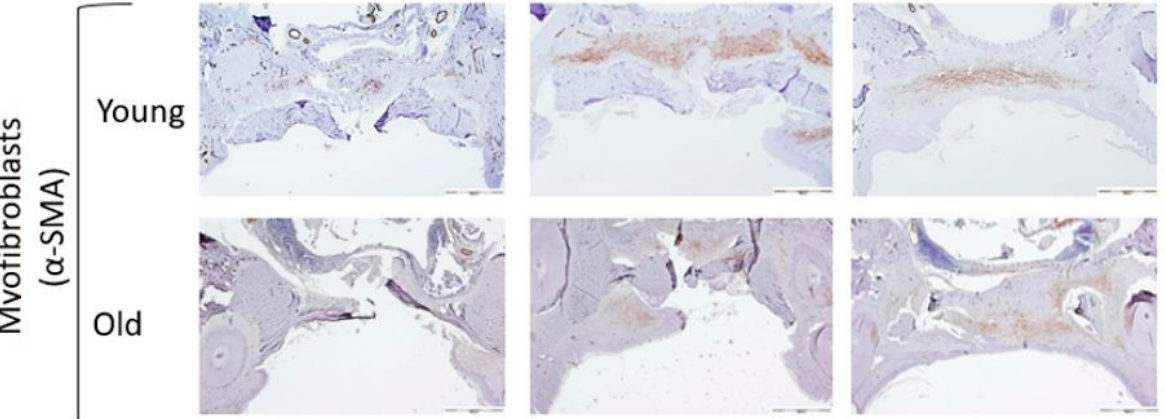
Figure 7. Representative photomicrographs of inflammation and myofibroblasts in young and old rats, weeks 1–3 (original magnification of all microscopic sections × 40). Scale bar 500 µ m. Hematoxylin and eosin stain (H&E), Alpha Smooth Muscle Actin ( α -SMA).